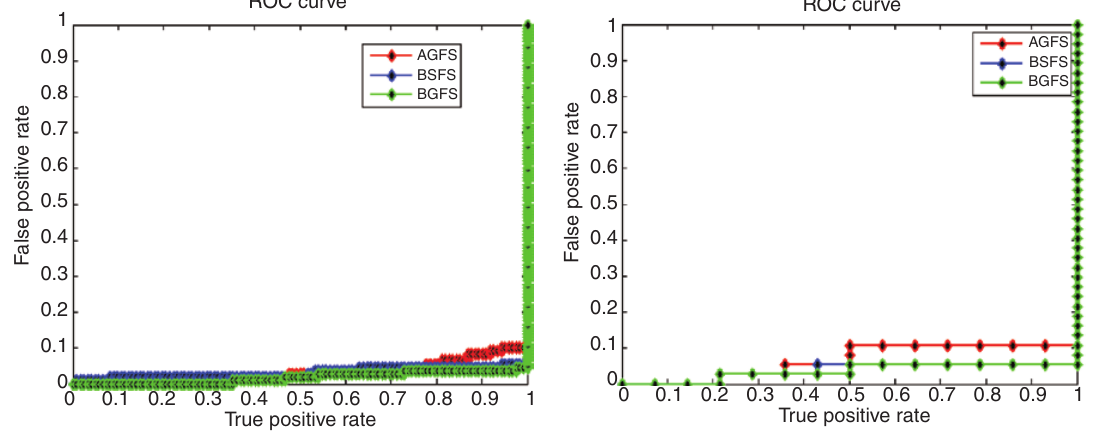
Figure 11: ROC Curve for DRD and Lung